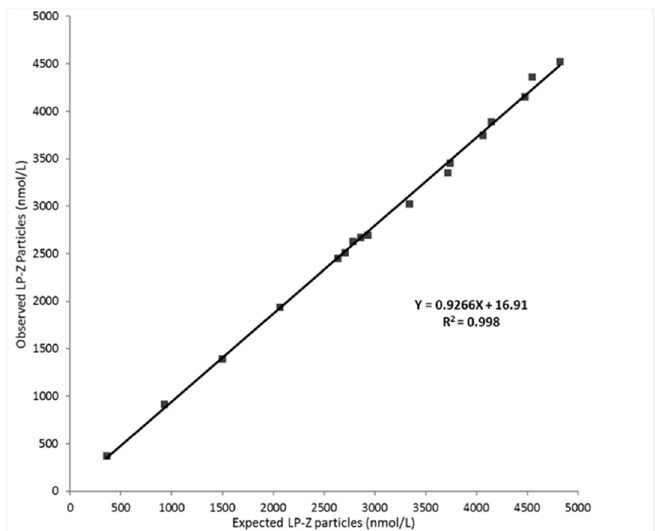
Figure 2. Linearity of expected versus observed LP-Z particles in serum. Linearity was evaluated by identifying and serially mixing serum pools that were predetermined by NMR to have low, medium, and high LP-Z levels.